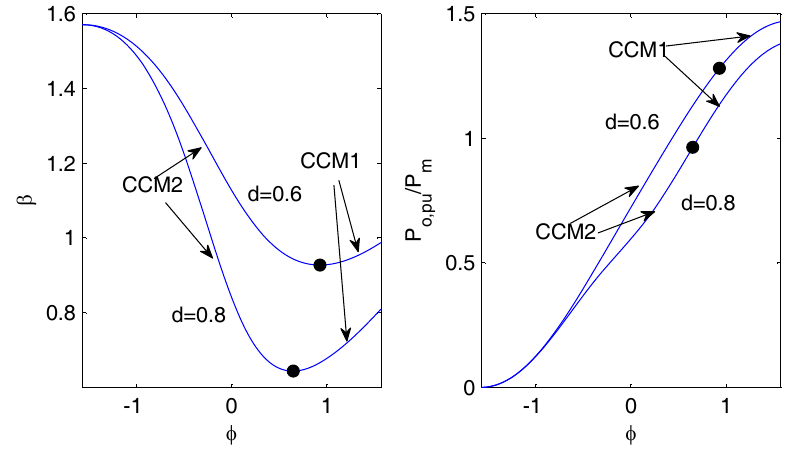
Figure 10. The variations of P o , pu / P m , β with regards to φ at d <